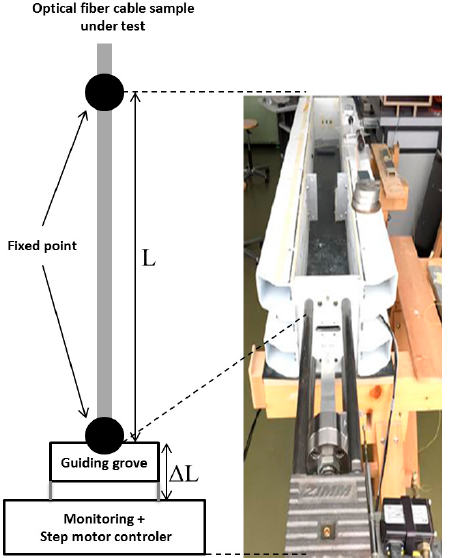
Figure 8 . Schematic representation ( left ) of the bench used to determine fibre optic cables’ sensitivities to strain and pictures ( right ) from Marmota Company. Adapted with permission from [23]. Copyright 2016 Optical Society of America Publishing.